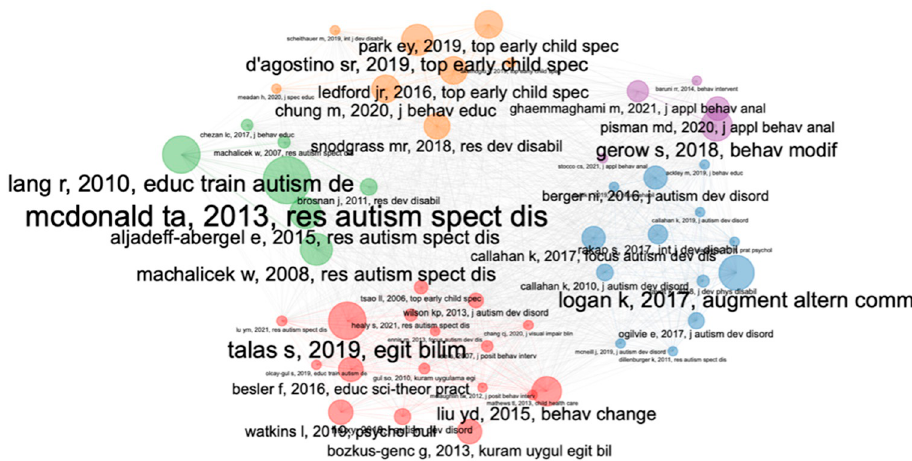
Figure 7. Bibliographic coupling analysis. Red cluster: Social skills